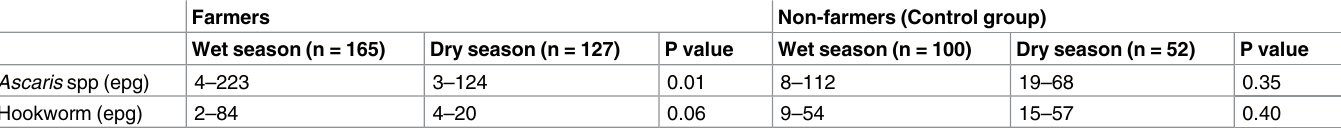
Table 2. Range of eggs per gram (epg) of Ascaris spp and hookworm infection intensity in wastewater farmersand a control group in Kumasi, Ghana. Farmers